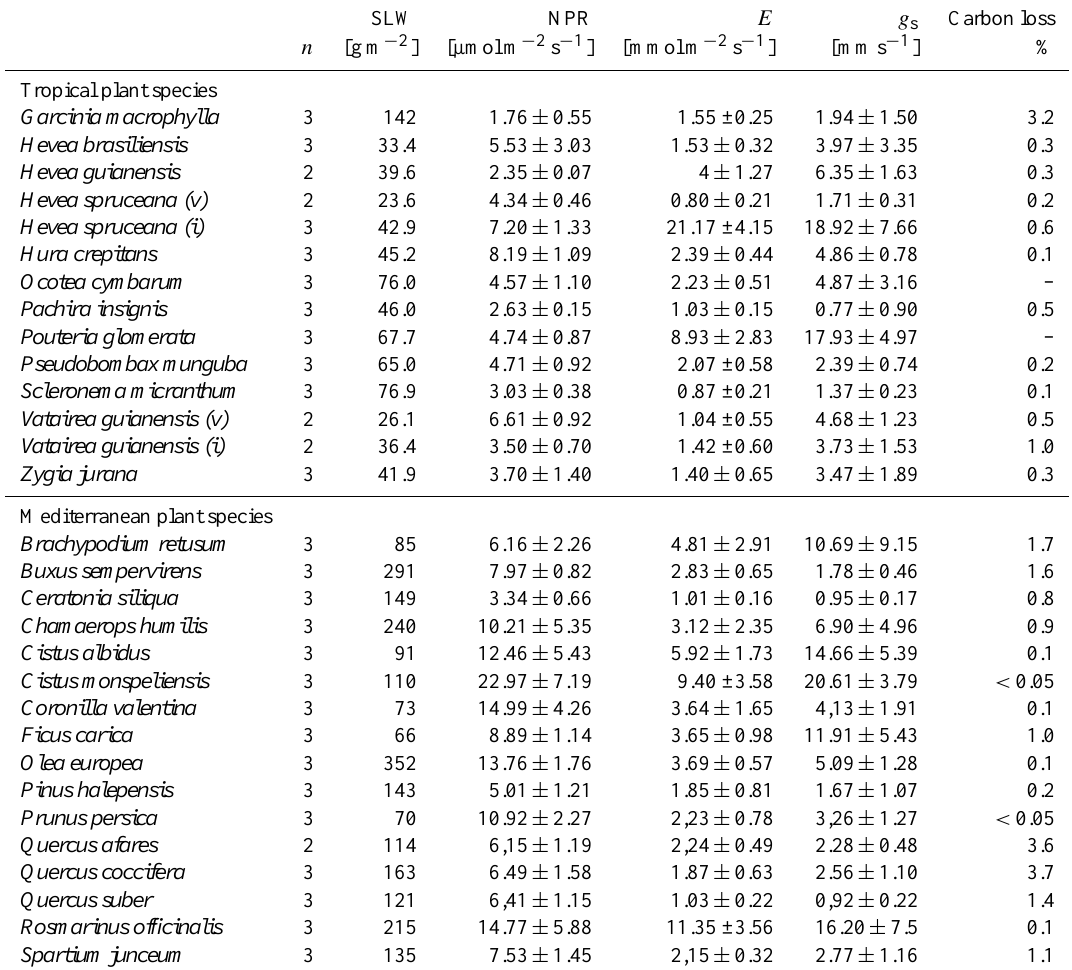
Table 7. Specific leaf weight (SLW), net photosynthetic rate (NPR), transpiration ( E ), and stomatal conductance ( g s ) for Mediterranean and tropical plant species. Carbon loss (VOC carbon in relation net CO 2 assimilation) is estimated from the mean values of NPS (this table) and the sum of VOC carbon derived from the species listed in Table 4. Except for SLW, all averages ± standard errors are calculated from < 100 samples (tropical) or 5–125 samples (Mediterranean) from n tree